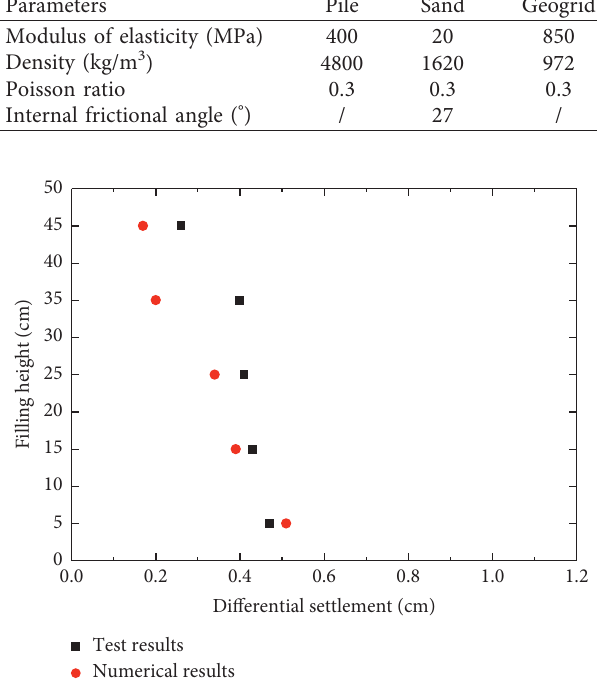
Figure 10: Comparison of differential settlement between the model test and numerical